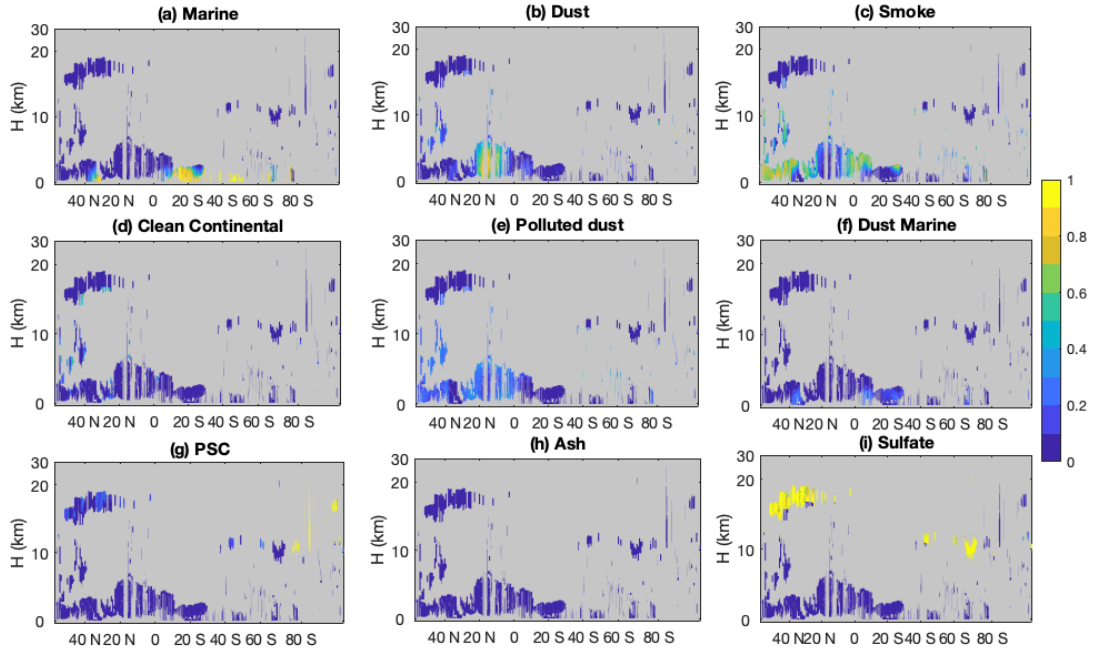
Figure 8. CNN classification scores assigned to all aerosol classes ( a ): marine aerosols; ( b ): dust; ( c ): smoke; ( d ): clean continental; ( e ): polluted dust; ( f ): dust marine aerosols; ( g ): PSC aerosols; ( h ): ash; ( i ): sulfate or other stratospheric aerosols) for nighttime data acquired on 14 July 2011, starting at 00:42:02 UTC, as shown in Figure 7.